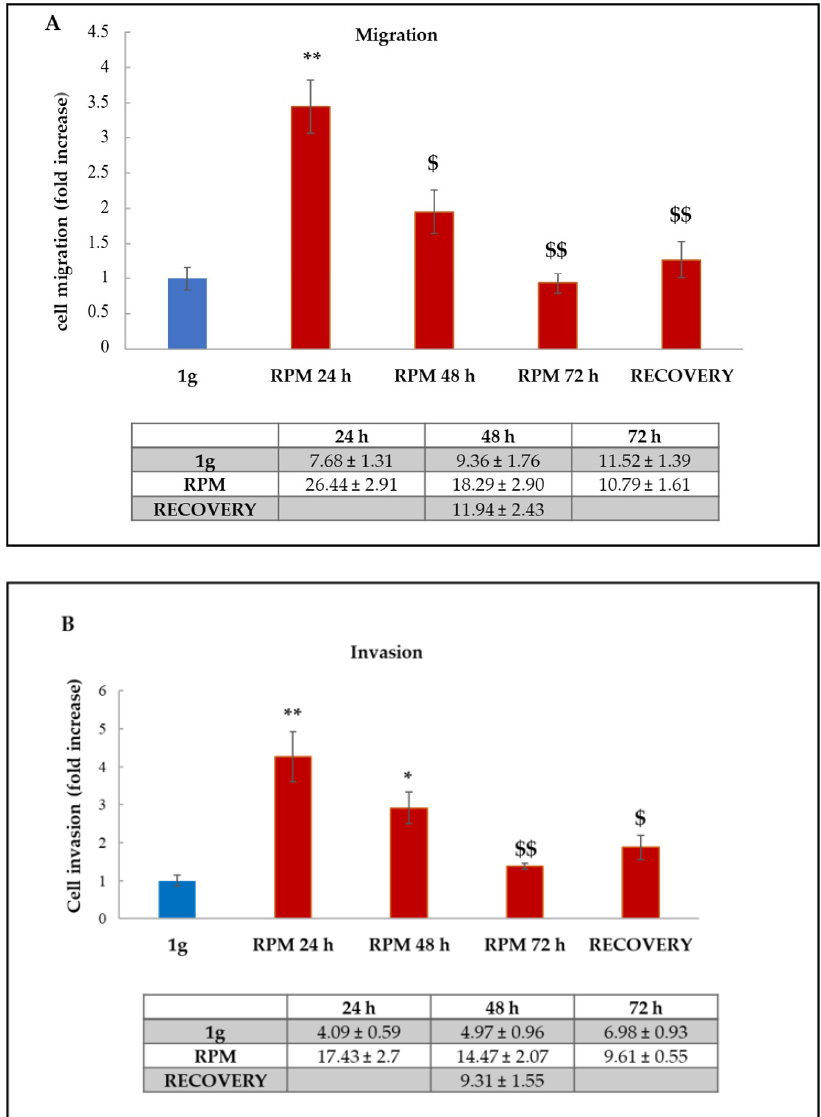
Figure 7. Effect of microgravity exposure in RPM on migration ( A ) and invasion ( B ) in HaCaT cells. Data expressed as fold increase of control value considered as 1 are means of three independent experiments, each performed in quadruplicate, with S.D. represented by vertical bars (* p < 0.05; ** p < 0.01 versus 1g control; $ p < 0.05; $$ p < 0.01 versus the cells exposed to RPM for 24 h by ANOVA followed by Bonferroni post-test). Tables illustrate the number of migrating and invading cells/field, respectively.